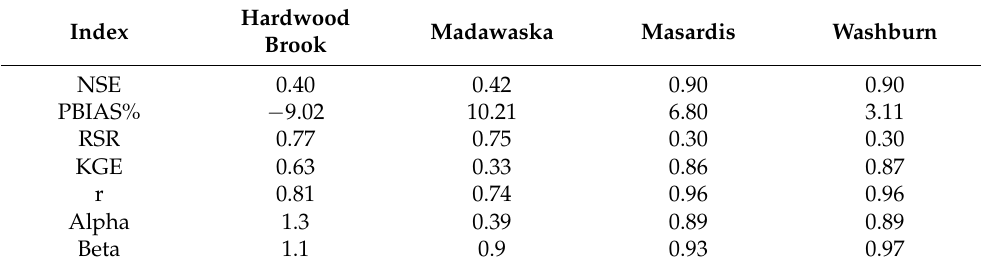
Table 5. NSE, PBIAS, RSR, and KGE for simulated runoff compared with the observed streamflow at the four USGS gage locations: Hardwood Brook, Madawaska, Masardis, and Washburn stations. Hardwood Madawaska Masardis Washburn Index Brook NSE